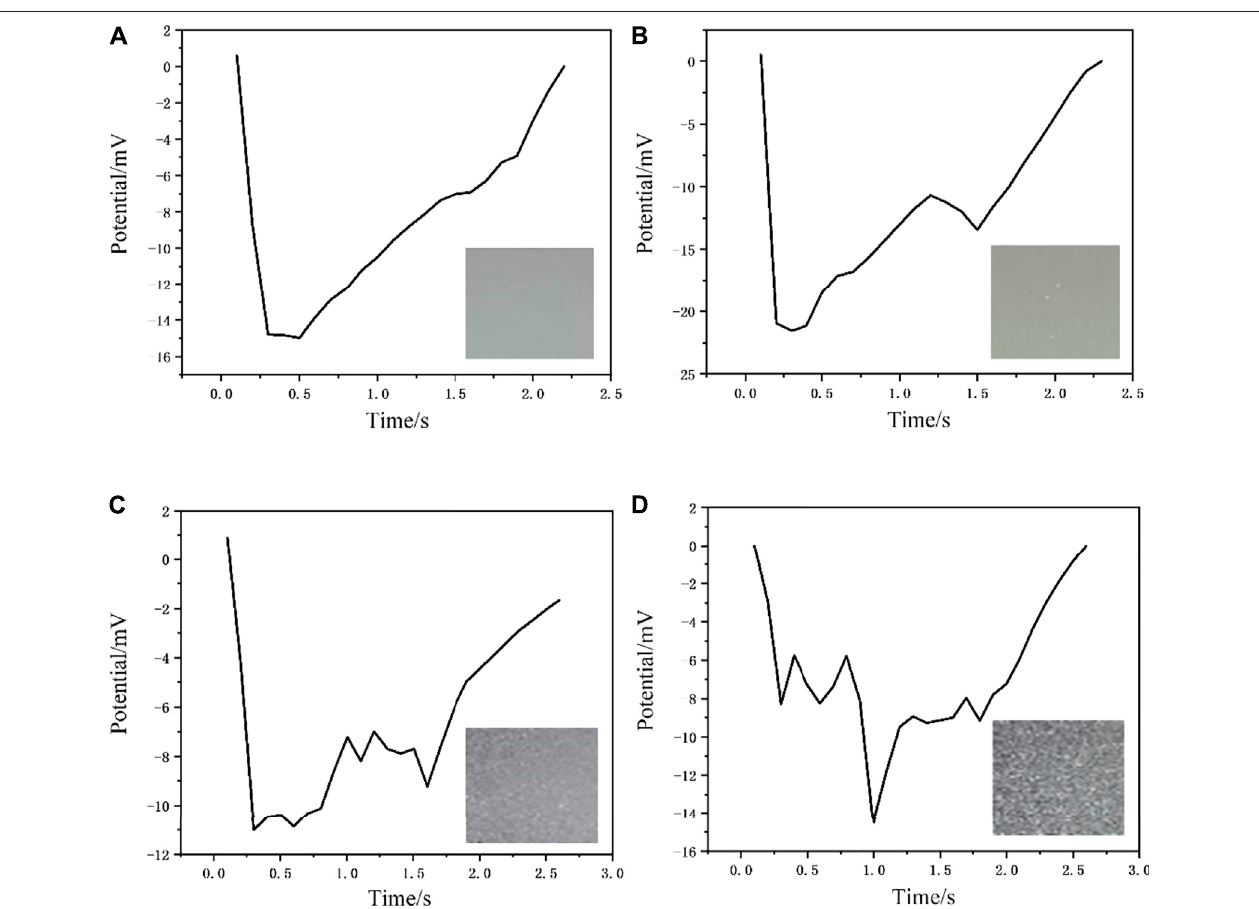
FIGURE9| Voltageresponseofsensorslidinguponsurfaceofdifferentroughness. (A) SmoothA4paper; (B) Sandpaperof800#; (C) Sandpaperofabout600#; (D) Sandpaper of about 320 #.